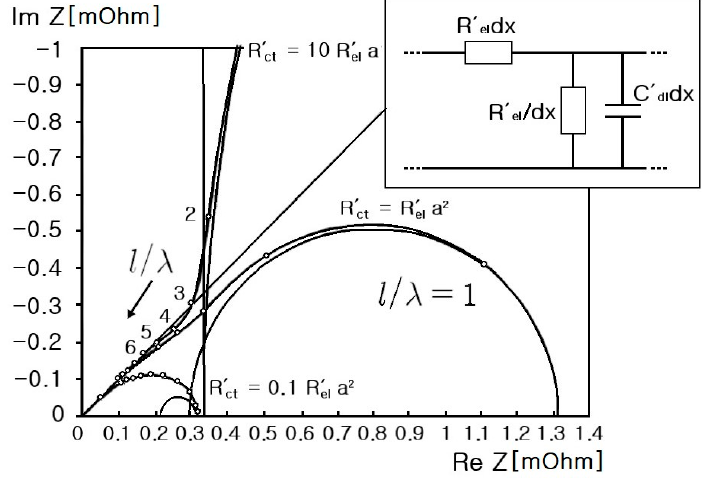
Figure 13. Theoretical model of the impedance spectrum of supercapacitors with porous elec-